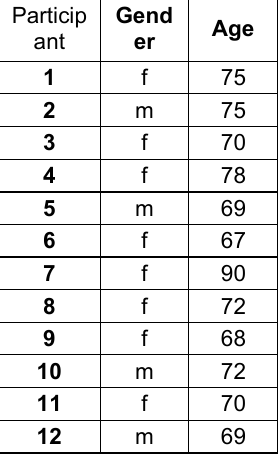
Table 1. Characteristics of initial study